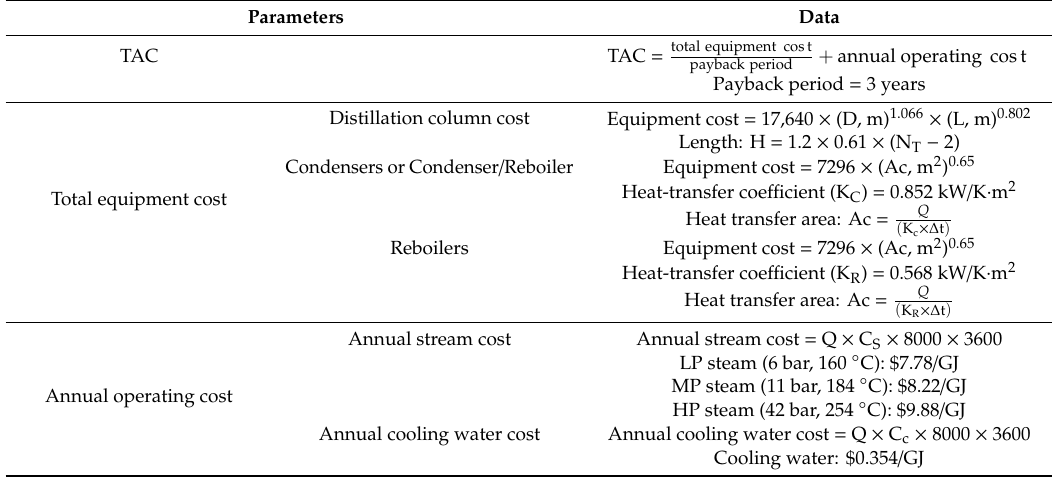
Table 2. Basis economics and equipment sizing.